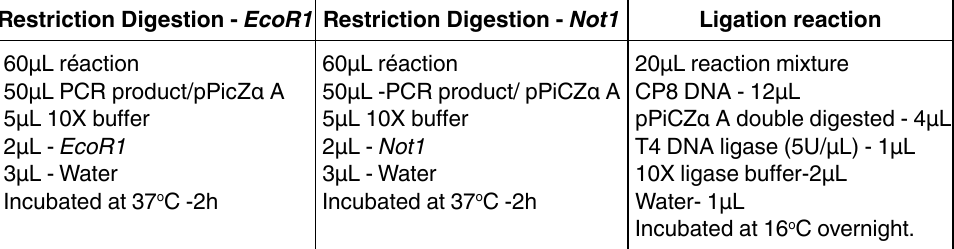
table 3. Cloning of Cysteine protease 8 gene into pPICZαA Pichia expression vector Restriction Digestion - EcoR1 Restriction Digestion - Not1 ligation reaction